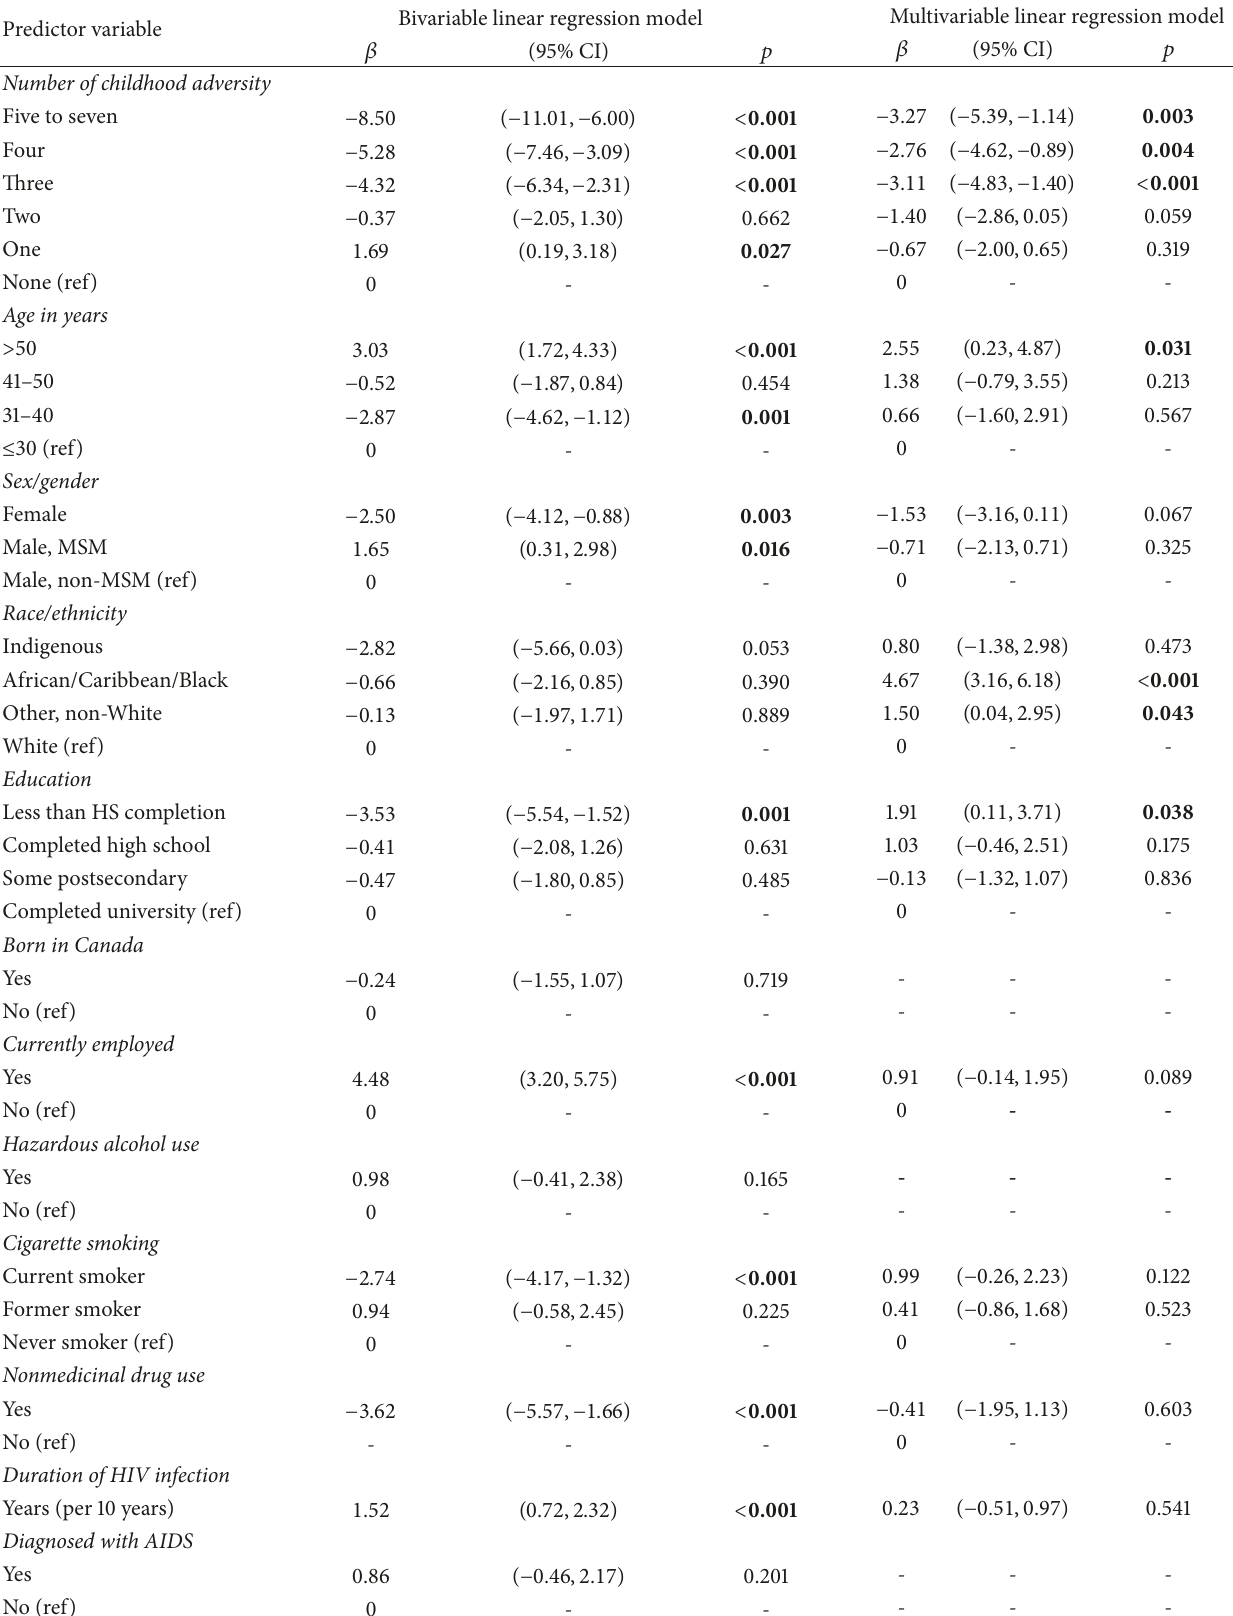
Table 5: Childhood adversities as predictors of SF-36 mental component summary (MCS) score: results from bivariable multivariable linear regression